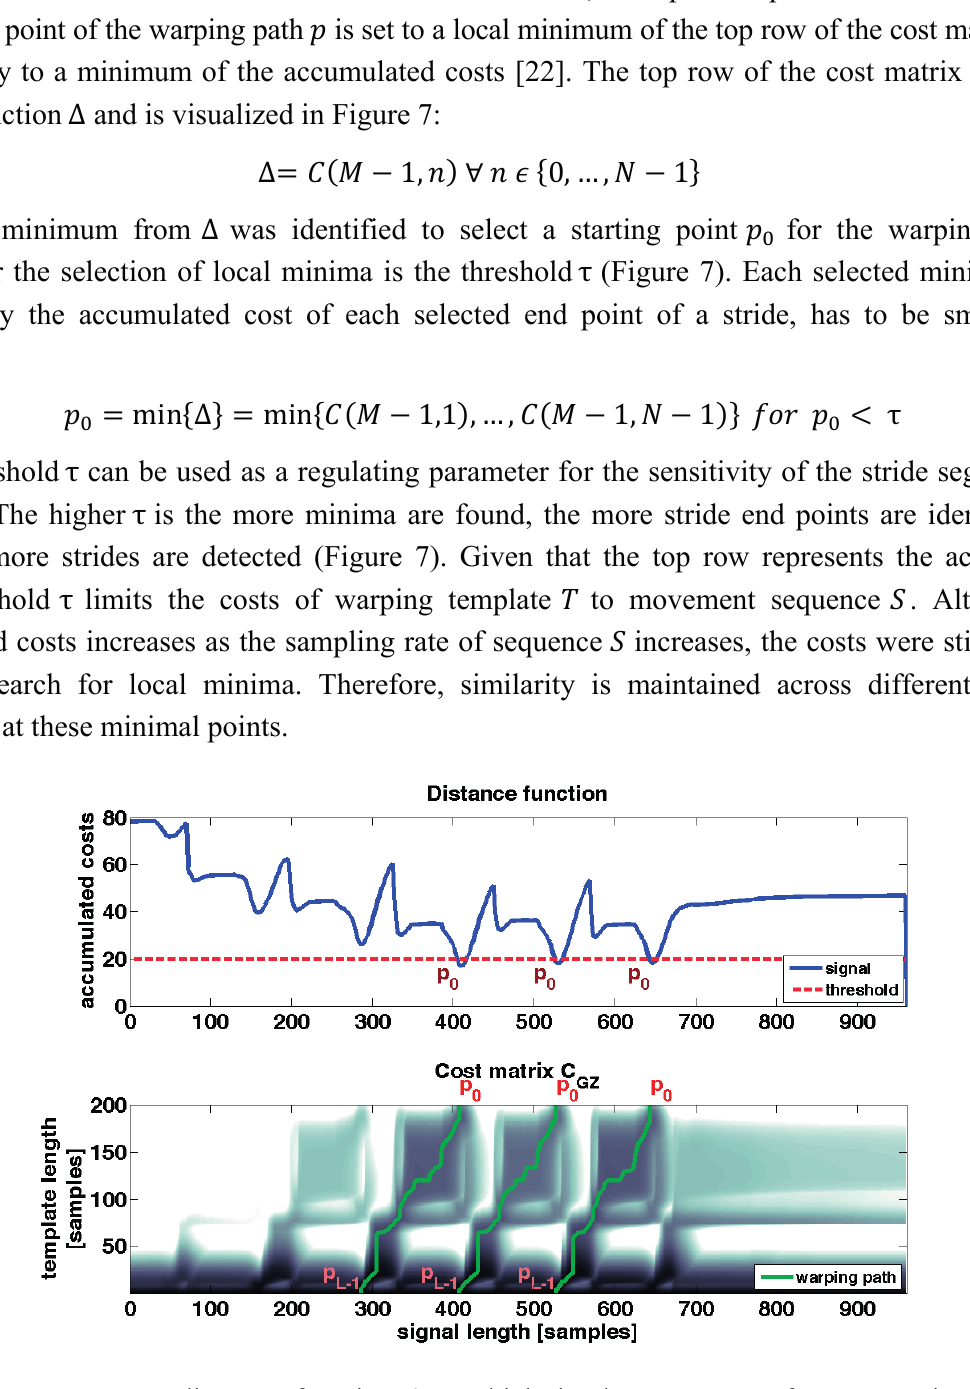
Figure 7. Upper : distance function ∆ which is the top row of cost matrix C GZ . (cid:3008)(cid:3027) Below : cost matrix C GZ . In the plot of the distance function also the threshold and three local minima are illustrated. These minima are the start points of the warping paths (cid:1868) . The plot of the cost matrix C GZ is overlaid with three warping paths which correspond to three segmented strides in the movement sequence S GZ